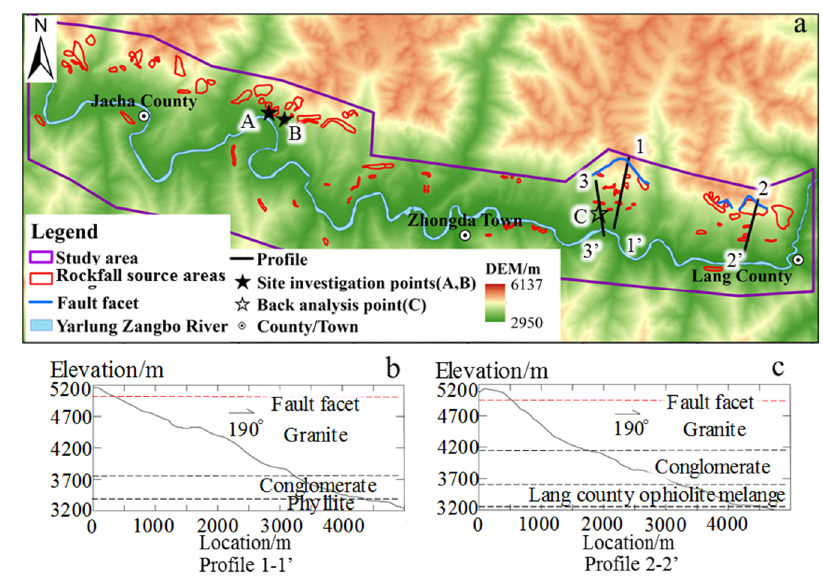
Figure 2. Elevation distributions of different lithology and distribution of rockfall source areas in study area ( a ). Distribution of rockfall source areas and positions of typical profiles ( b , c ). Elevation distributions of different lithology are in profile 1-1′ and 2-2′.